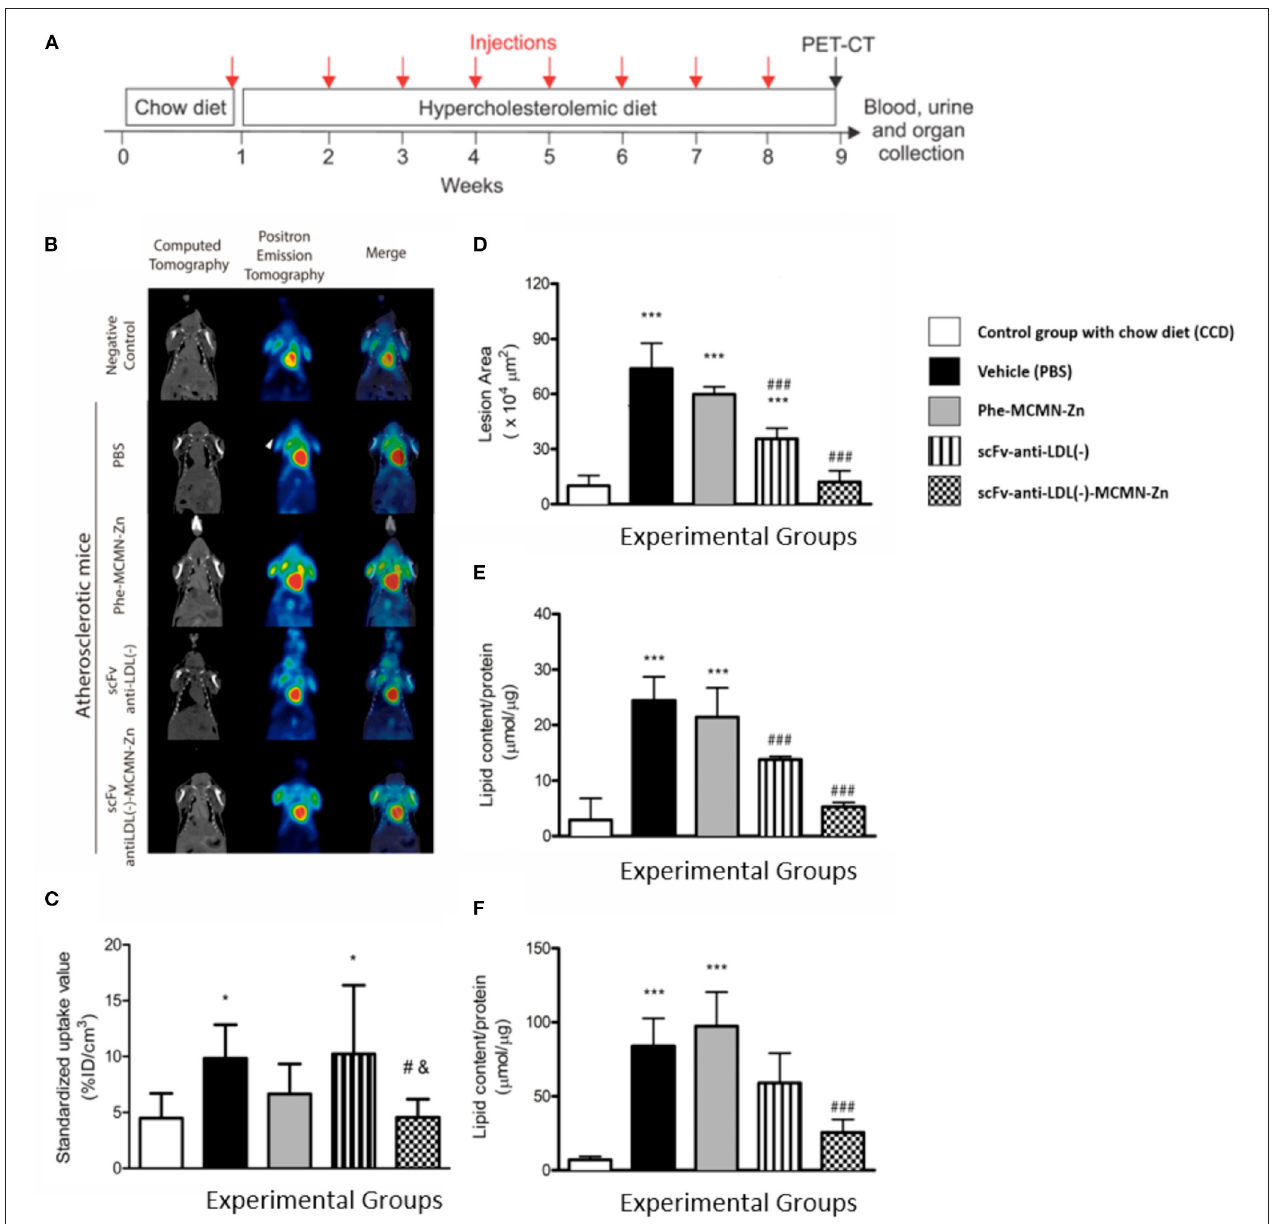
FIGURE 6 | Weekly intravenous administration of scFv-anti-LDL(-)-MCMN-Zn nanoformulation prevents atherosclerosis development. (A) Scheme showing the experimental protocol; 12-week-old male Ldlr − / − mice were fed a semi-synthetic hypercholesterolemic diet (0.5% w/w cholesterol). Mice were divided into 5 groups ( n = 5 per group) and received weekly injections of PBS (vehicle group), 5 × 10 5 particles/Kg of body weight of Phe-MCMN-Zn nanocapsules, 5mg scFv-anti-LDL(-)/Kg of body weight and scFv-anti-LDL(-)-MCMN-Zn nanoformulation [corresponding to 5mg of scFv-anti-LDL(-)/Kg of body weight]. A control group was fed chow diet without any treatment (CCD). After 8 weeks of treatment, the atherosclerotic lesions at the aortic arch of mice were evaluated by 18 F-FDG PET/CT imaging. Blood, urine and heart were collected to further analysis. (B,C) Representative coronal 18 F-FDG PET/CT images (B) and standardized uptake value analysis (C) of the 18 F-FDG retention in the aortic arc region. (D) Quantification of the atherosclerotic lesion areas ( × 10 4 µ m 2 ) in the aortic arch of Ldlr − / − mice. (E,F) Measurement of lipid content in the aorta (E) and in the aortic arch (F) of Ldlr − / − mice. * p < 0.05 and *** p < 0.001 in relation to CCD control group; # p < 0.01 and ### p < 0.001 compared to the PBS group and & p < 0.01 compared to scFv-anti-LDL(-)-treated group.